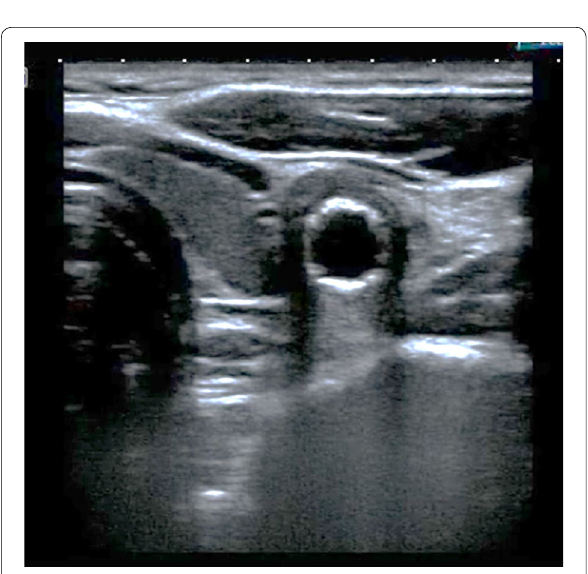
Fig. 6 Ultrasound of carotid after stenting: Transverse